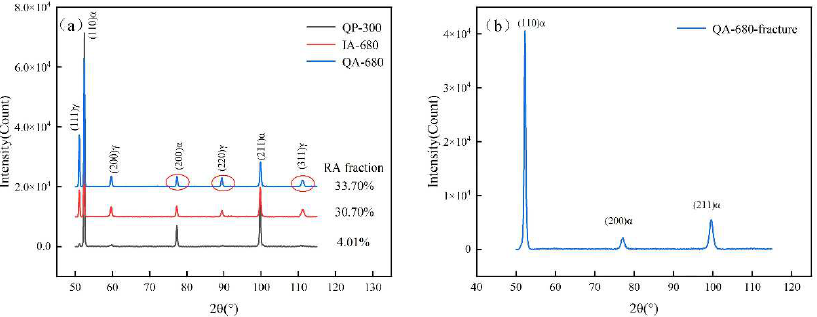
Figure 13. XRD results of ( a ) QP-300, IA-680, QA-680 and ( b ) fractured QA-680 specimens.